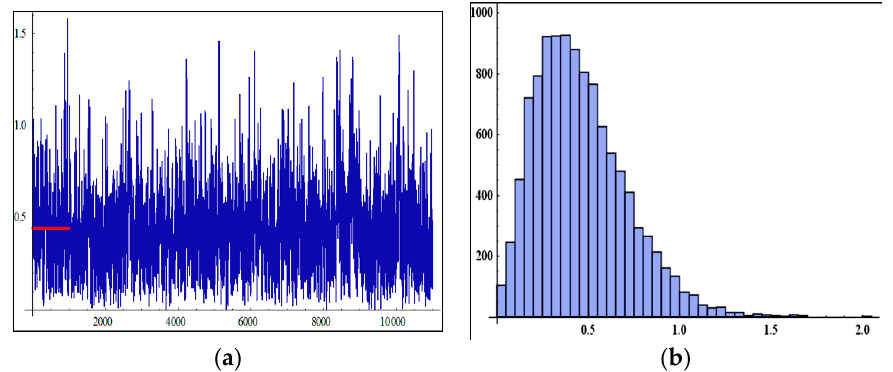
Figure 3. ( a ) Simulation number of α obtained by MCMC method. ( b ) Histogram of α obtained by MCMC